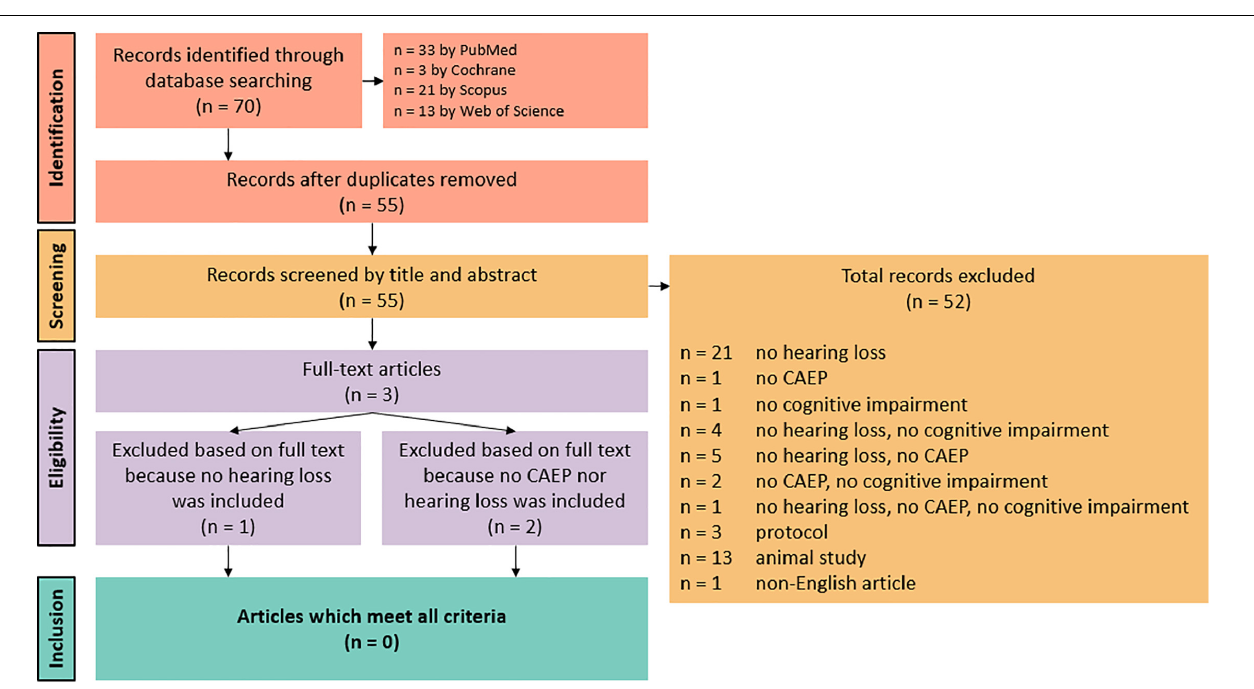
FIGURE 1 | Flow diagram of study inclusion. CAEP, cortical auditory evoked